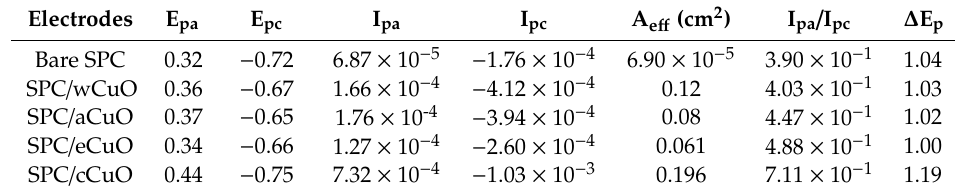
Table 2. Electrochemical parameters of bare SPC and electrodes modified with CuO nanoparticles.